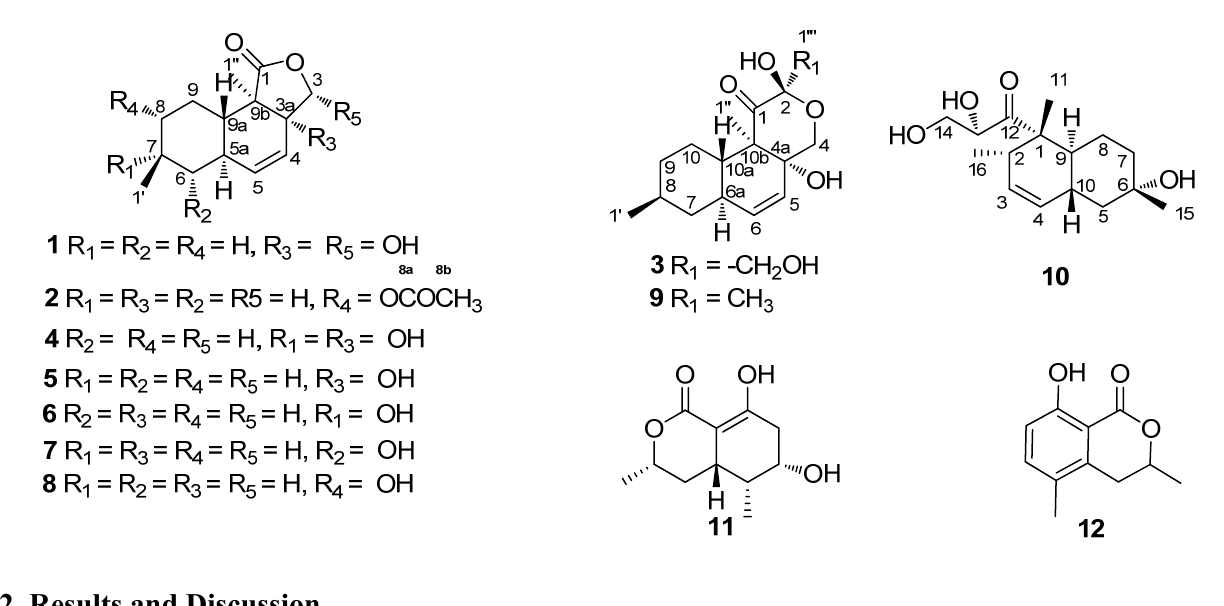
Figure 1. Structures of compounds 1-12